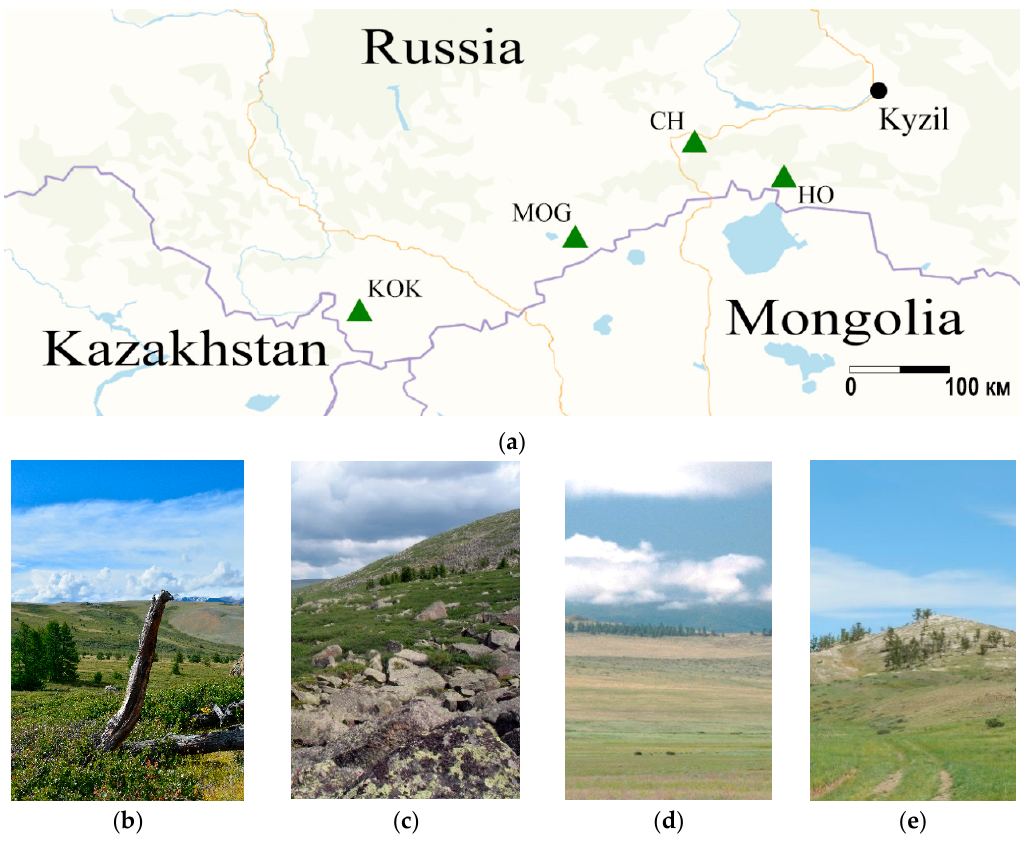
Figure 1. A map with a location of the studied sites (Mongun (MOG), Koksu (KOK), Ersin (HO) and Chadan (CH)) in the Altai-Sayan Mountain Range (ASMR) ( a ). Photos of the Larix sibirica Ledeb. trees at the MOG site ( b ), KOK ( с ), HO ( d ) and CH ( e ) sites. Photos were made during the fieldwork studies and archived at the Siberian dendrochronological laboratory at the Siberian Federal University, Russian Federation. Table 1. Study sites and local weather stations used for the climatic analysis (Figure S1). Air temperature data in brackets were recalculated according to the altitude, ◦ C / 100 m